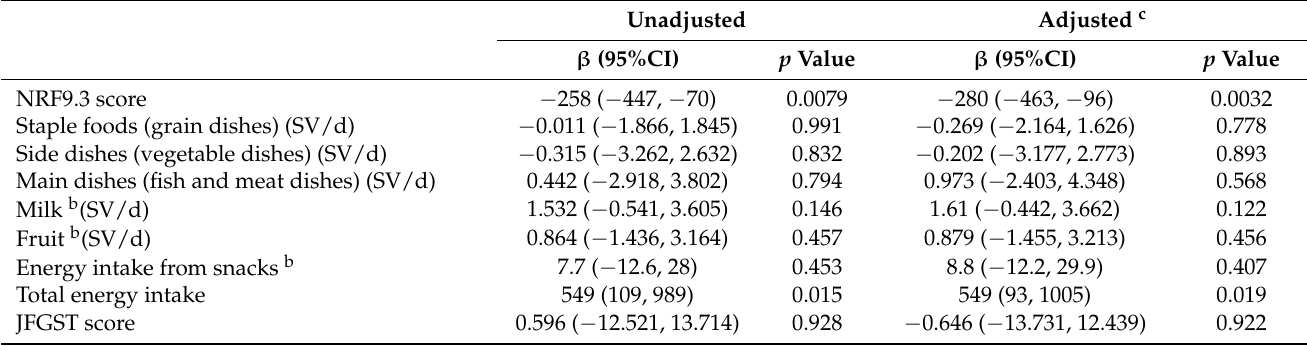
Table 4. Association of pre-pregnancy BMI a with NRF9.3 and total energy intake. Unadjusted Adjusted c β (95%CI) p Value β (95%CI) p Value